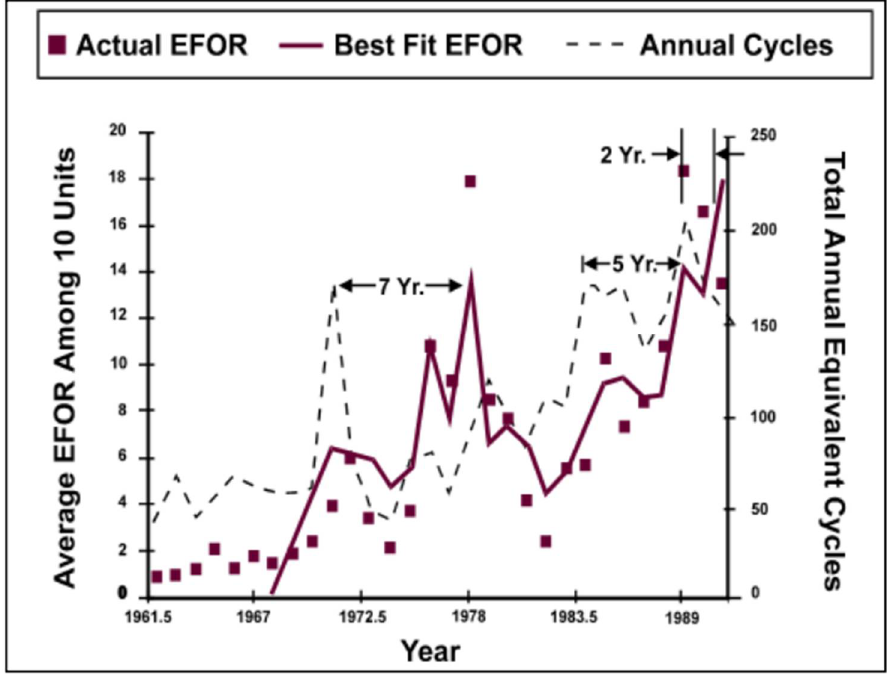
Figure 4. Cycling effects on the equivalent forced outage rates. Reprinted from Ref. [53] .